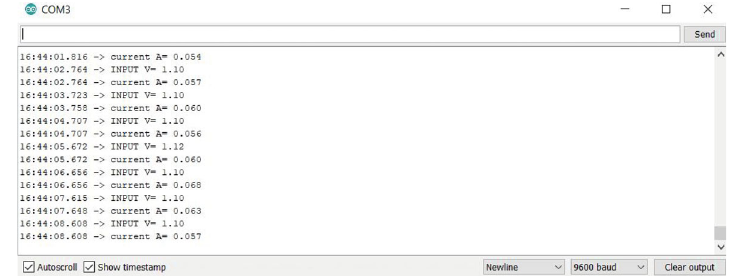
Figure 9: Monitoring power generation of Solar PV emulator.